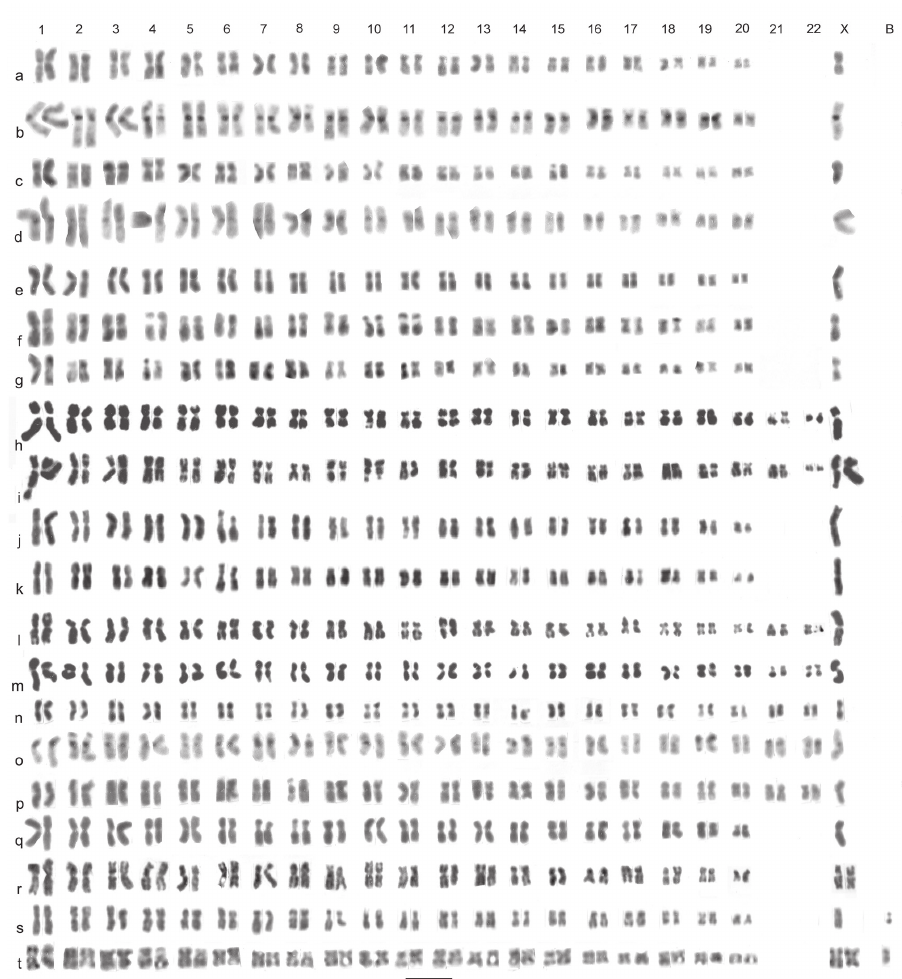
Figure 5. Colymbetes ( a–g ) and Rhantus ( h–t ), mitotic chromosomes arranged as karyotypes. a , b C. fuscus , ♂ , mid-gut a Pinail, plain b Wisley, C-banded c , d C. paykulli , ♂ , midgut, Mullsjö c plain d C-banded e C. piceus , ♂ , Egypt, mid-gut, plain f , g C . striatus, ♂ , mid-gut, plain h , i R. grapii , ♂ , mid-gut, plain j , k R. exsoletus , ♂ , mid-gut, plain j Studland Heath k Gayton Thorpe Common l , m R. frontalis , ♂ , plain l mid-gut, Gayton Thorpe Common m testis, Thompson Common n–p R. suturalis , ♂ n , o mid-gut, Staines Moor n plain o C-banded p testis, Ras Az Zawr, Kuwait, plain q–t R . suturellus , plain q ♂ , testis, Pinail r–t Studland Heath r ♀ mid-gut s ♂ mid-gut with 1 Bchromosome t ♀ mid-gut with 1 B-chromosome. Bar = 5